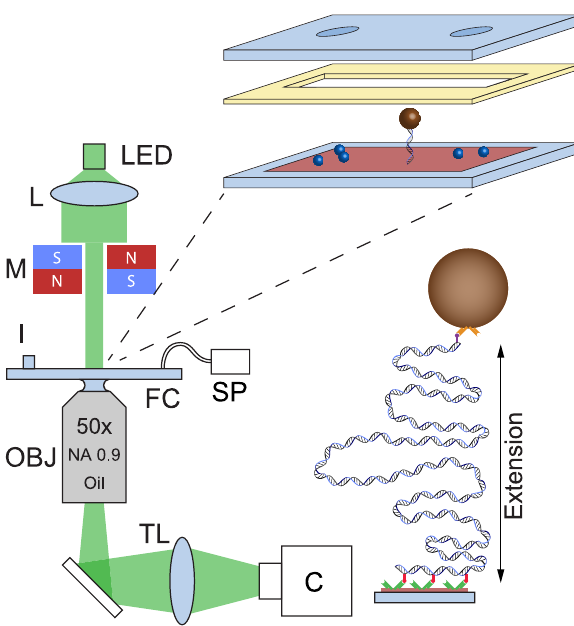
Figure 1. Magnetic tweezers apparatus used in this study. An LED provides illumination via a collimating aspheric lens, L, through magnet assembly M. The flow cell is imaged via a 50 | objective (Nikon NA 0 : 90 Oil) in conjunction with a 200 mm achromatic doublet tube lens, TL, onto a CMOS camera. The flow cell is constructed from two type 1 coverslips, the top one of which is sandblasted to create two 3 mm holes for fluid entry and exit. Paraffin wax film is used to separate the two coverslips and create a flow cell volume of approximately 100 m l . The bottom coverslip is coated with both polymer microspheres to act as reference beads and nitrocellulose. To anchor the DNA to the nitrocellulose, anti-digoxigenin is incubated in the flow cell before addition of BSA, followed later by previously built microsphere-DNA constructs. Sample is pipetted into the inlet, I, and removed via syringe pump,